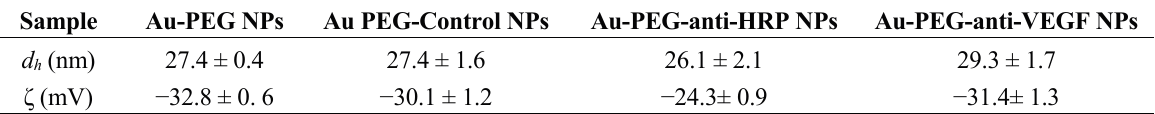
Figure 10. Number distribution N ( ζ ) of the zeta-potential of ( a ) Au-PEG NPs, ( b ) Au-PEG-control NPs, ( c ) Au-PEG-anti-HRP* NPs, ( d ) Au-PEG-anti-VEGF* NPs, ( e ) Au-PEG-anti-HRP NPs, and ( f ) Au-PEG-anti-VEGF NPs. The concentration of the NP solutions were c NP ≈ 5 nM, and the measurements were performed in milliQ water. Each sample was measured at least three times and the mean value of the zeta-potential was determined. Table 3. Summary of mean hydrodynamic diameters and zeta-potentials determined in